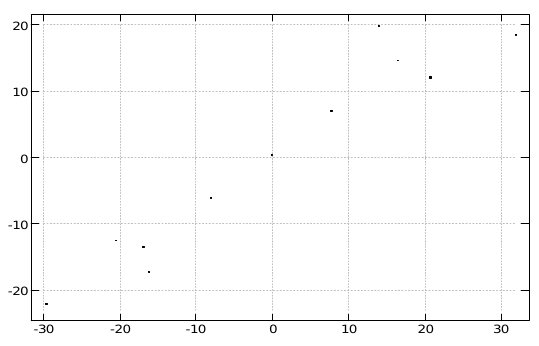
The proximity matrix shows, by bolding of small proximity values, that there are 3 clusters with objects 1- 5 in one cluster, object 6 in another cluster and objects 7-11 in the 3 rd cluster. This was intended in the generation of the proximity matrix. Figure 1 shows a visual representation of the IO ( inter-object ) data obtained by the SMACOF algorithm. The visual representation supports the result of a visual inspection of the proximity matrix but also shows other possible partitions.